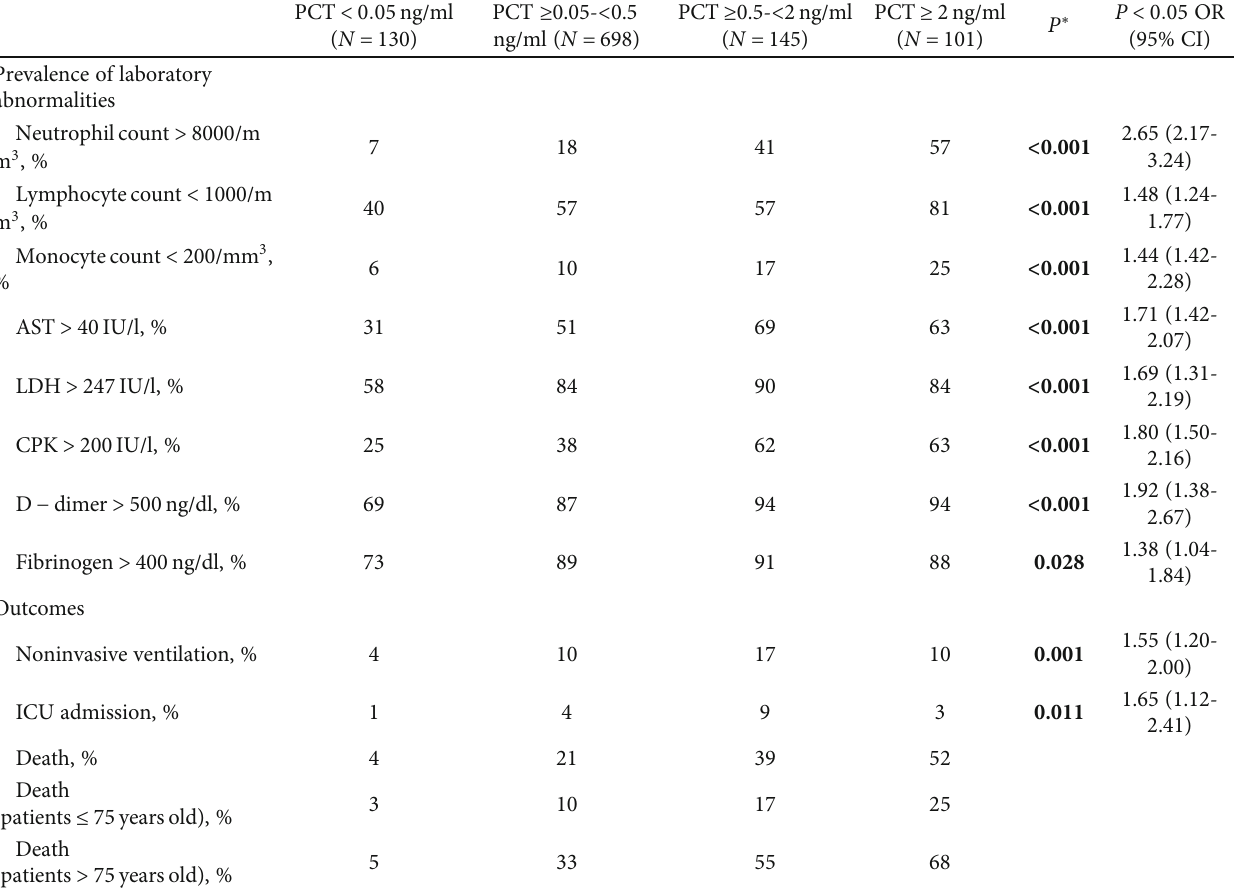
Table 4: Prevalence of the main laboratory abnormalities and outcomes of the 1074 study participants, strati fi ed according to procalcitonin